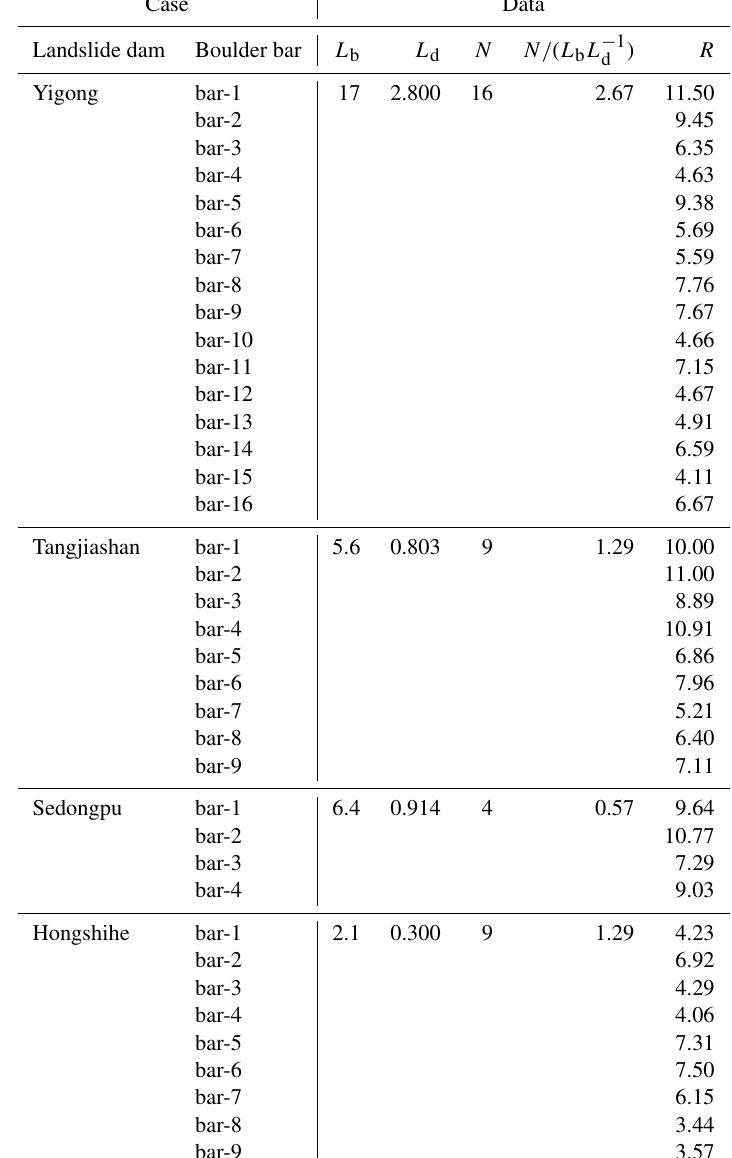
Table 3. Field case data obtained through Google Earth. L b is riverbed length (km); L d is dam bottom length (km); N is the number of boulder bars ( − ); R is the ratio of a boulder bar’s length to width ( −